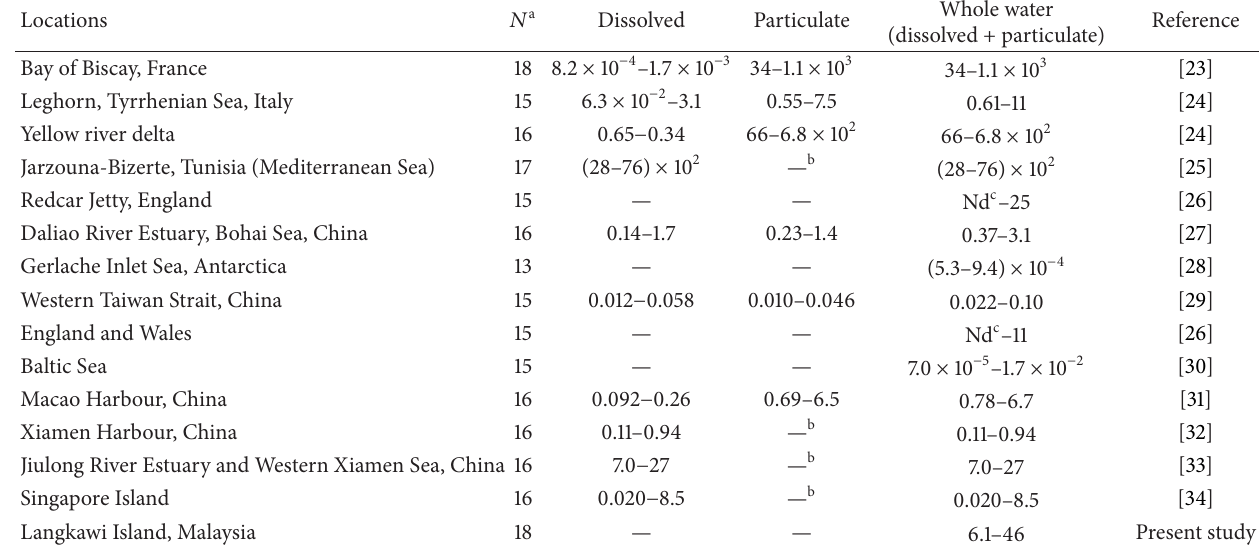
Table 3: Reported PAHs concentrations ( 𝜇 gL − 1 ) in the particulate and dissolved phase of surface seawater in different areas of the world.